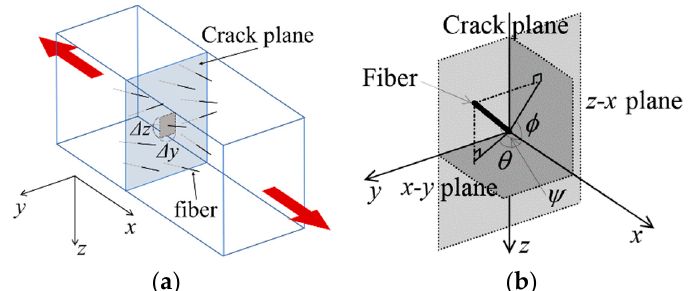
Figure 2. Schematic drawing for the calculation of bridging law: ( a ) fibers bridging through crack plane and ( b ) definition of fiber inclination angle.